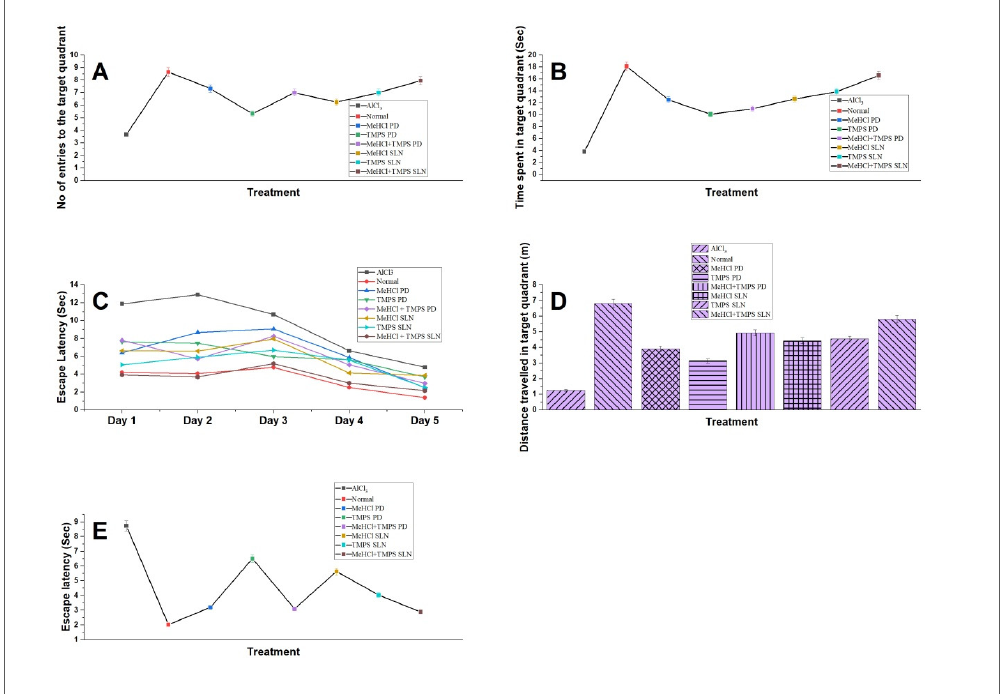
Figure 12. Daily administration of MeHCl & TMPS improved spatial memory in rats which was demonstrated by the ( A ) No. of entries in the target quadrant ( B ) Time spent in the target quadrant ( C ) Learning pattern in the training phase ( D ) Distance travelled in the target quadrant ( E ) Escape latency where all the results showed that AlCl 3 induced AD and M + T SLNs showed the best results in comparison with other treatment groups. All the data is represented in mean ± SD ( n = 3) with p < 0.01.